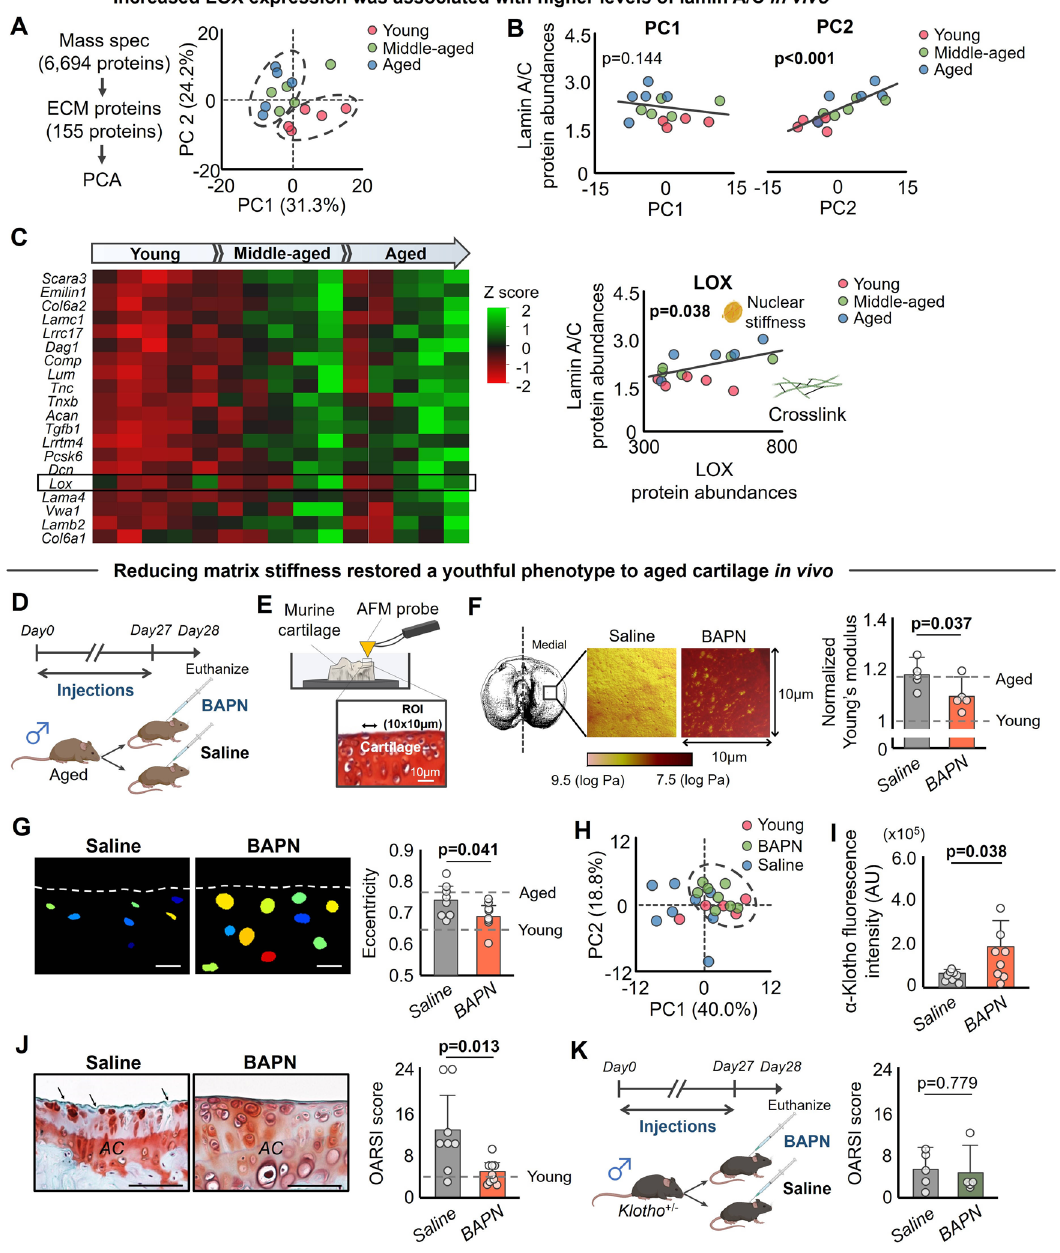
Fig.7|BAPNinjectionimproves α -Klothoexpressionandcartilageintegrityin agedmice.A Principalcomponentanalysis(PCA)showingtheseparateclustersin ECMproteinsfromyoungandagedcartilage( n =5/group). B Principalcomponent 2 (PC2) in ECM protein expression is positively correlated with lamin A/C expres- sion. C Heat map of the top 20 ECM proteins contributing to PC2, showing age- related ECMremodeling. Colorindicates z score foreachvariable. Lox, anenzyme thatinducescollagen cross-linking, wasin the top 20proteins contributingtoPC2 and was positively correlated with lamin A/C, supporting a connection between LOX-mediated increased collagen cross-linking and nuclear stiffness. D Schematic showing the experimental protocol for 4 weeks of daily BAPN injections in aged mice ( n =8 for saline, n =9 for BAPN). E Schematic showing the atomic force microscopy measurement of murine medial tibial cartilage with 10×10 µ m region of interest. F BAPN treatment signi fi cantly reduced Young ’ s modulus of medial tibial cartilage ( n =5/group). Young ’ s modulus data were transformed into